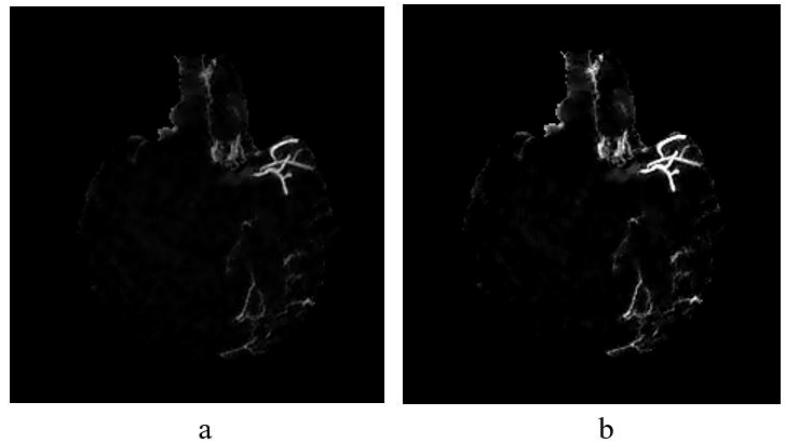
Figure 8. ( a ) The result of implementing top-hat transformation on the Wiener filtered image and ( b ) Contrast adjustment of top-hat transformed image.